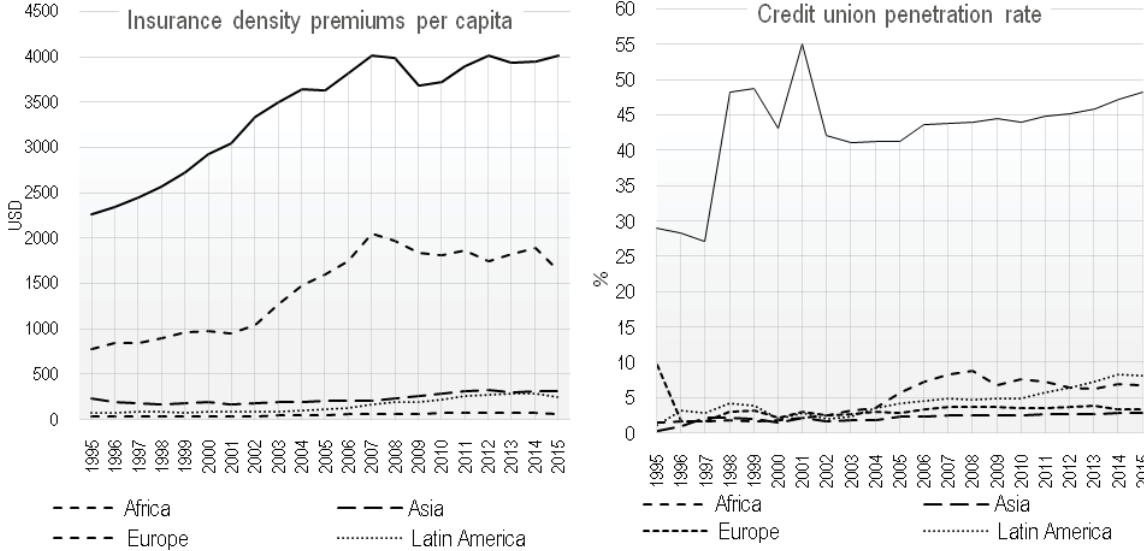
Fig. 1. Accessibility level dynamics to insurance companies and credit unions services during 1995-2015 among regions of the world Source: The Global Findex Database (2014); Sigma